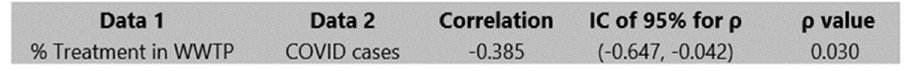
Figure 4. Correlation results between positive cases of COVID-19 and percentage of treated wastewater in Mexico, a significant negative correlation (r = − 0.385) was found between both variables ( p = 0.030).